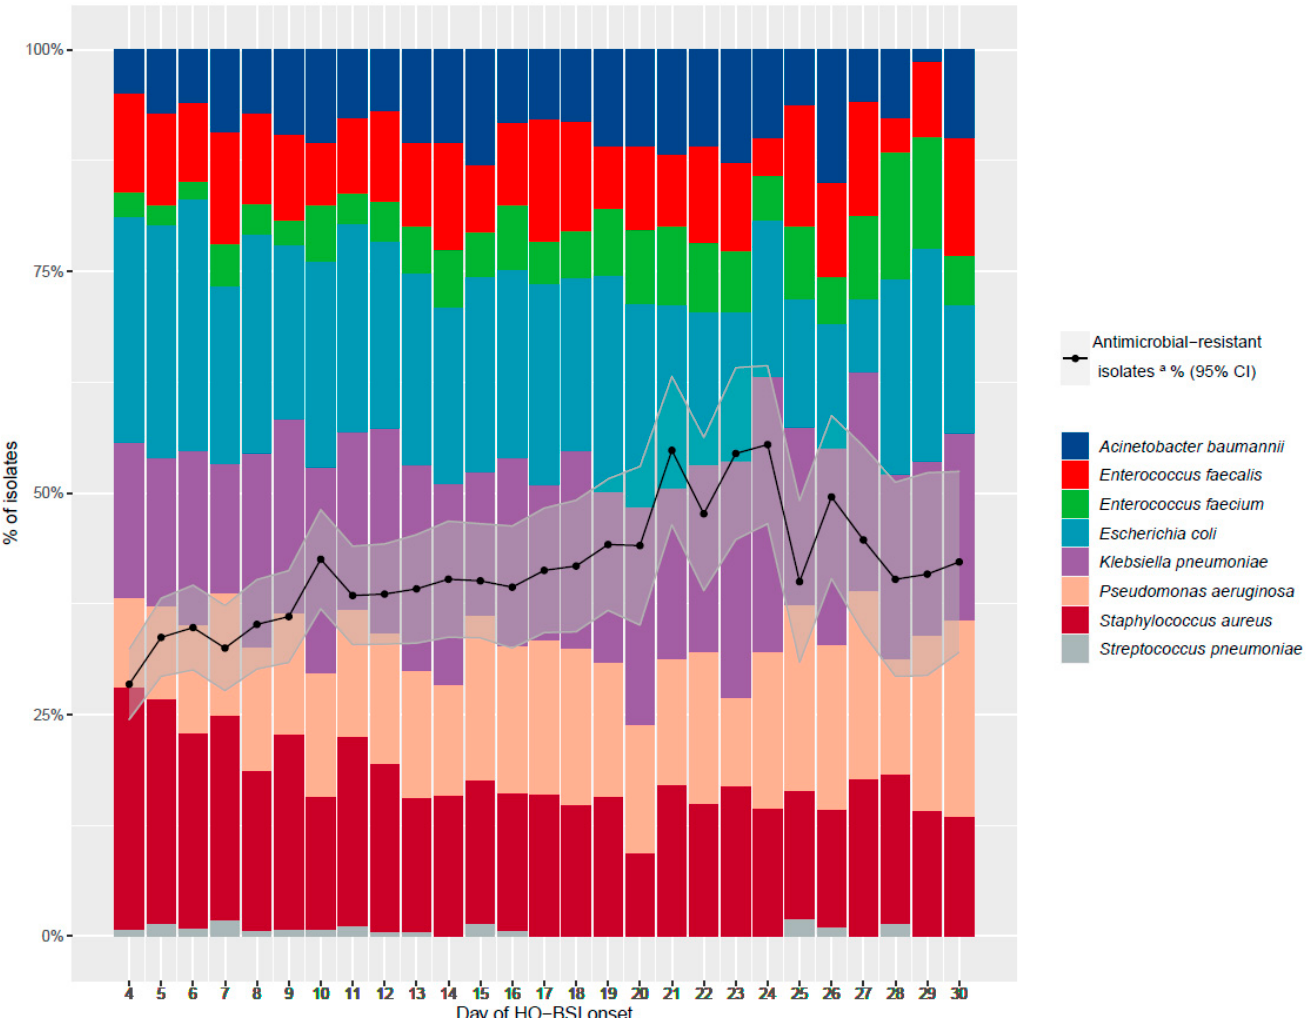
or cefoxitin resistance in S. aureus ; vancomycin or teicoplanin resistance in E. faecalis and E. faecium ; extended-spectrum cephalosporin (3rd and 4th generation) resistance in E. coli and K. pneumonia aeruginosa .